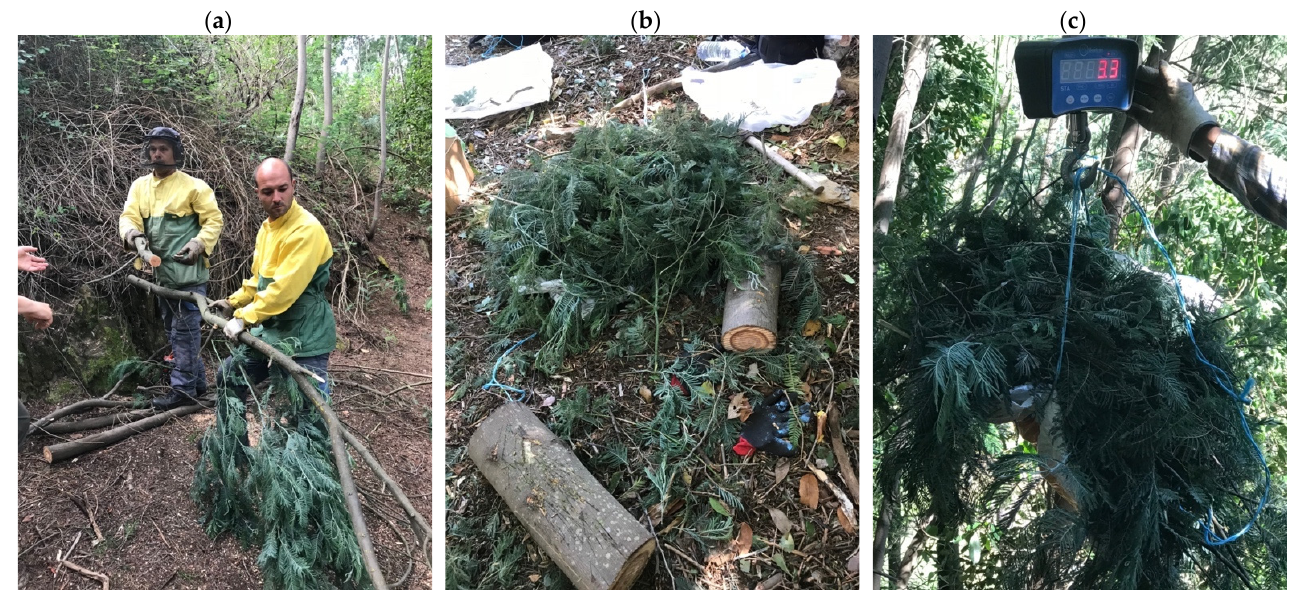
Figure 2. Collection of samples on site. ( a ) Cutting of trees; ( b ) separation of the different parts (trunk and branches/foliage); ( c ) weighing the different parts.